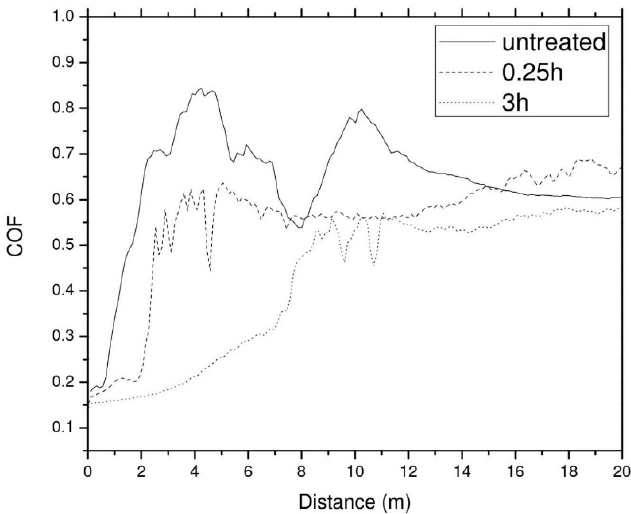
Figure 6. Dynamic friction coefficient variation, as a function of sliding